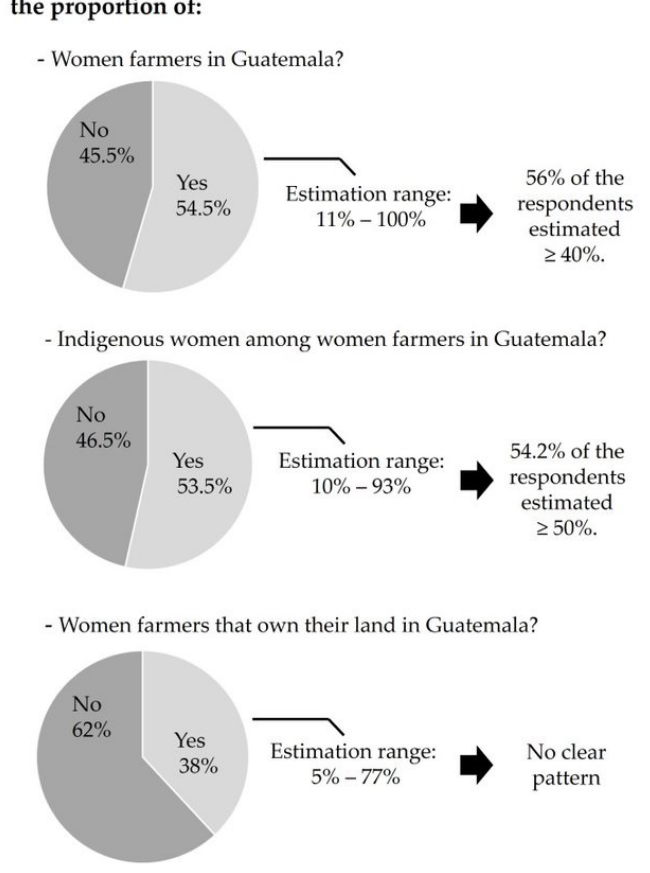
Figure 5. Survey results: estimation of gender-related indicators based on extensionists’ knowledge of census data.